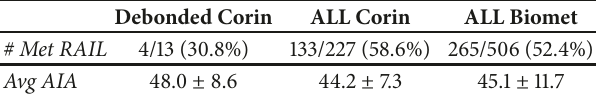
Table 6: Acetabular position